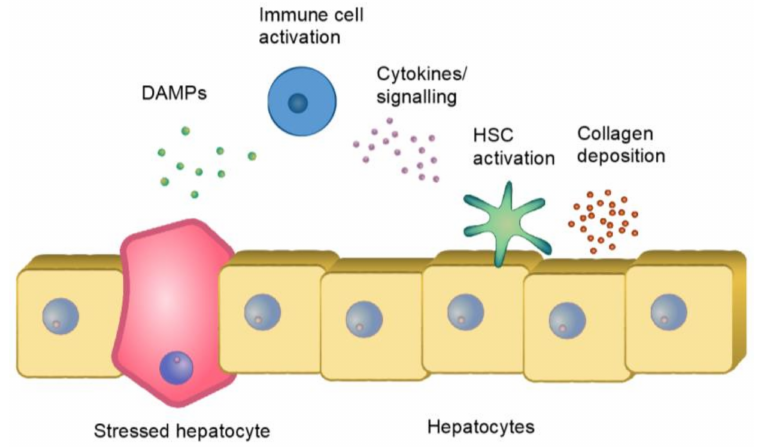
Figure 1. Schematic overview of a potential fibrotic cascade in occurring in the liver sinusoid microenvironment, from hepatocyte injury, via immune cell activation and signaling, to increased production of extracellular matrix (collagens) from hepatic stellate